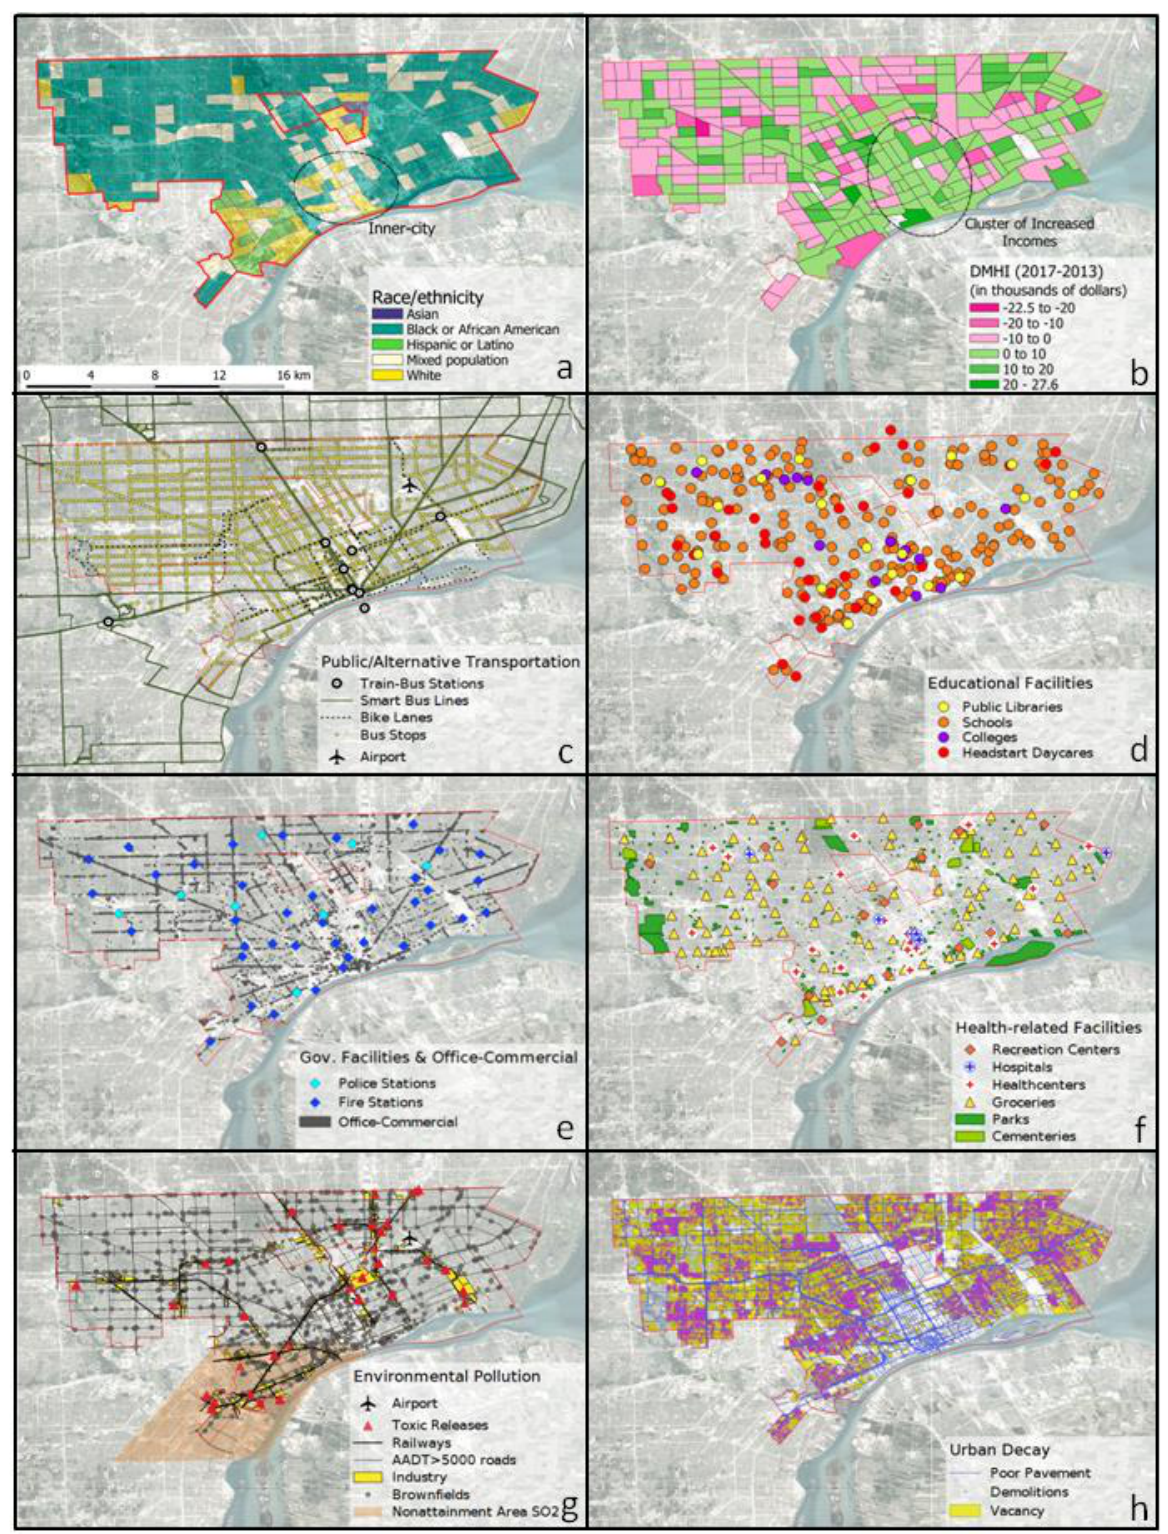
Figure 1. Urban and environmental features of Detroit, Michigan: ( a ) the study area including the city limits (red outline), inner-city location (black oval), and predominant racial/ethnic group by census tract (2011 – 2015 American Community Survey, U.S. Census Bureau), ( b ) the geographic distribution of difference of median household income (DMHI) between 2013 and 2017 by census tract, ( c ) public and alternative transportation, ( d ) educational facilities, ( e ) government assets and commercial or office areas, and ( f ) health-related facilities and green areas, ( g ) environmental pollution, and ( h ) urban decay features.